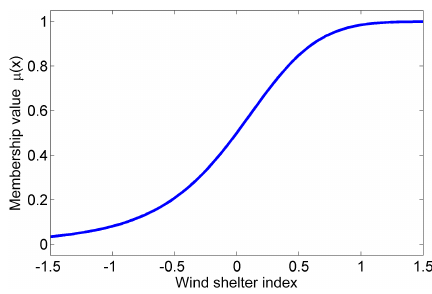
Figure 2. Fuzzy membership function for slope. Figure 3. Fuzzy membership function for wind